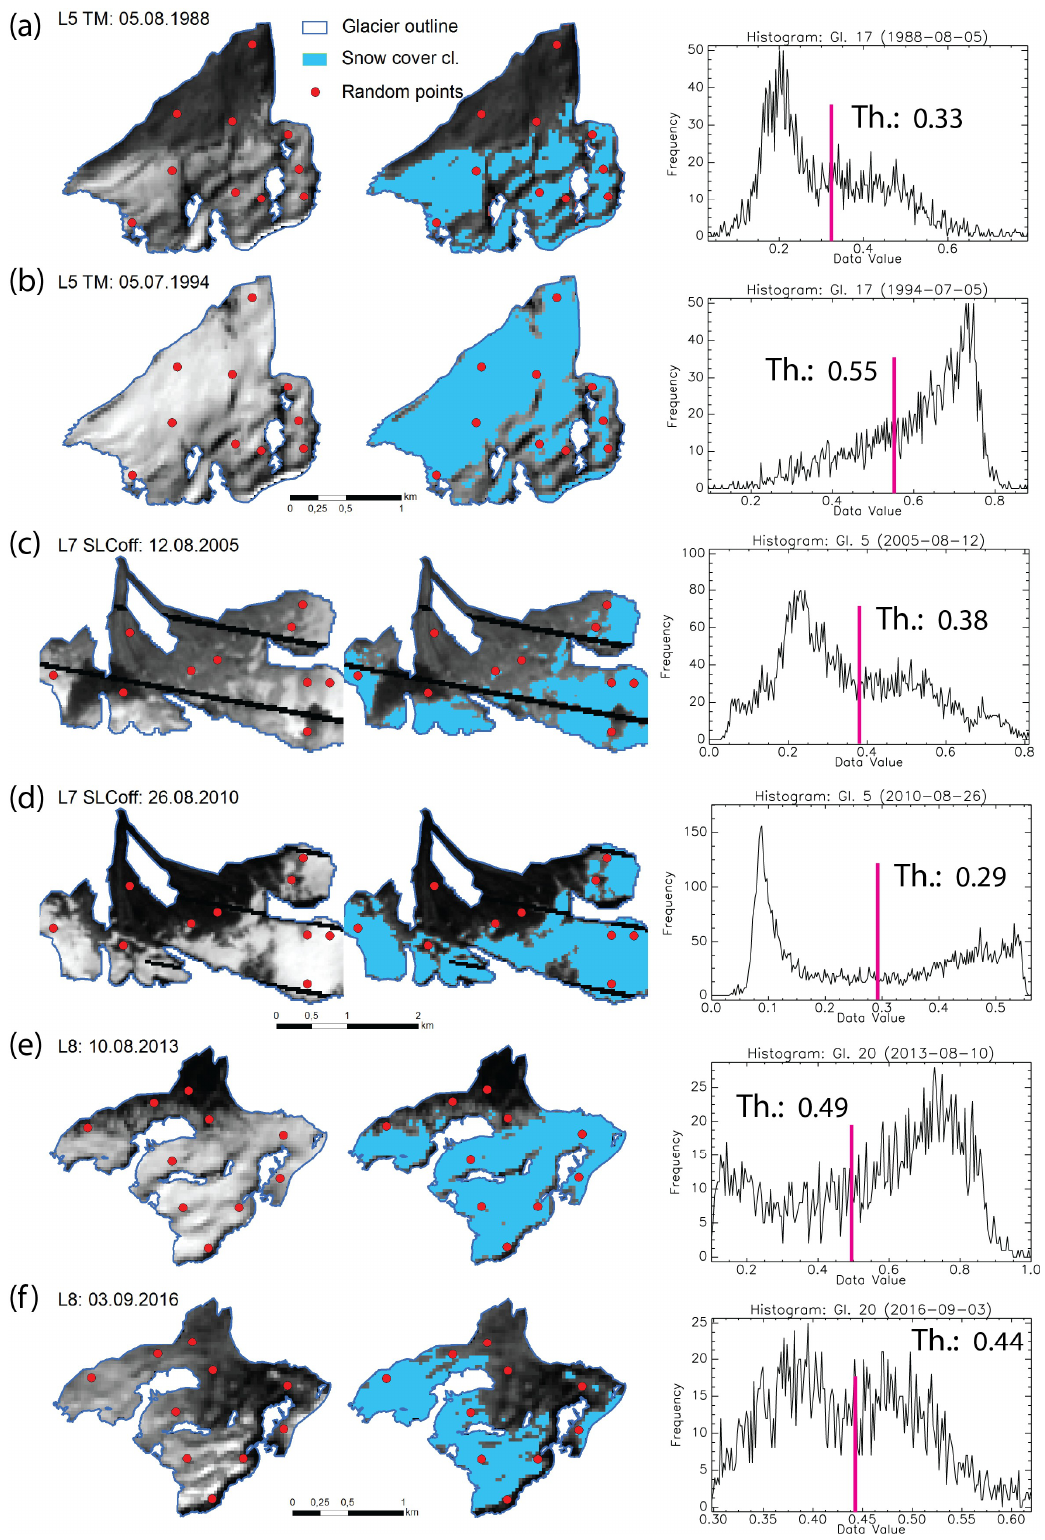
Figure 3. Snow cover mapping for glacier no. 17, 5 and 20 and different Landsat sensors. Left: The Ekstrand corrected NIR band. Center: The snow classification (light blue). Right: The respective histogram of the Ekstrand corrected image along with the automatically derived threshold. The histograms are not always exactly bimodal. The red dots indicate the location of sample points used for validation.